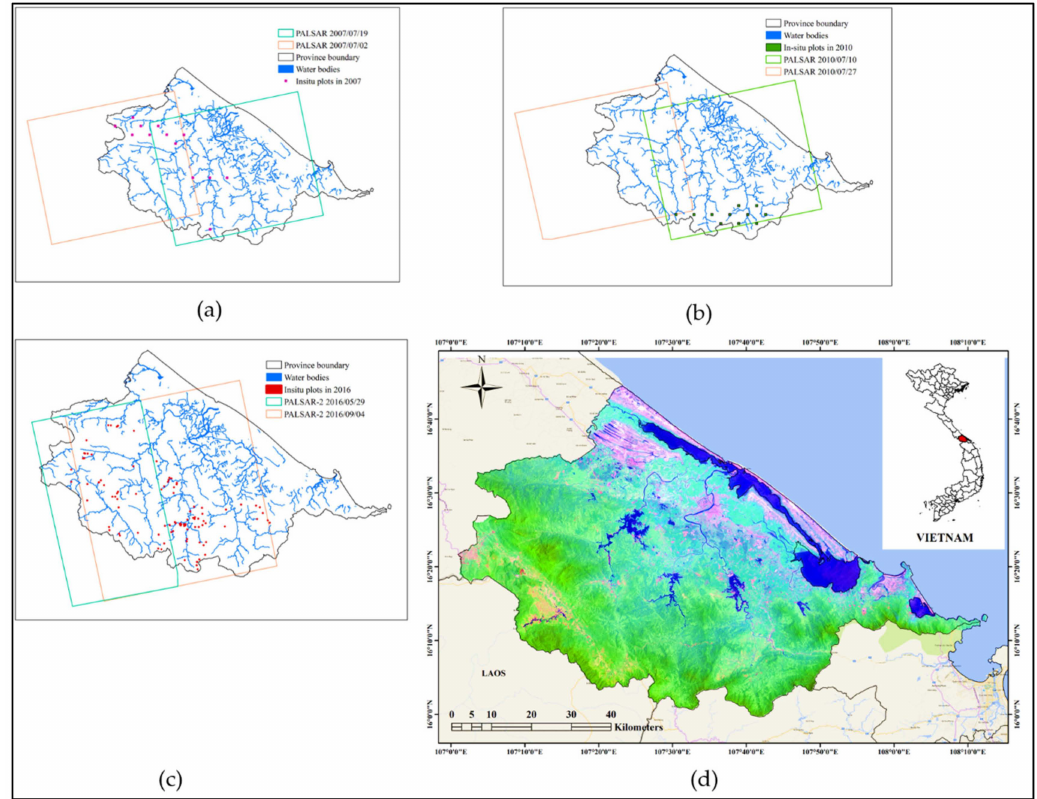
Figure 1. Cover of synthetic aperture radar (SAR) images and in-situ data in ( a ) 2007, ( b ) 2010, ( c ) 2016, and ( d ) location map of the study area in Landsat data with pseudo colors (R: SWIR 2, G: near-infrared, B: